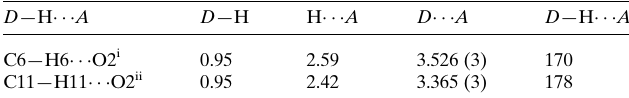
Table 1 Hydrogen-bond geometry (A˚ , (cid:3) ).